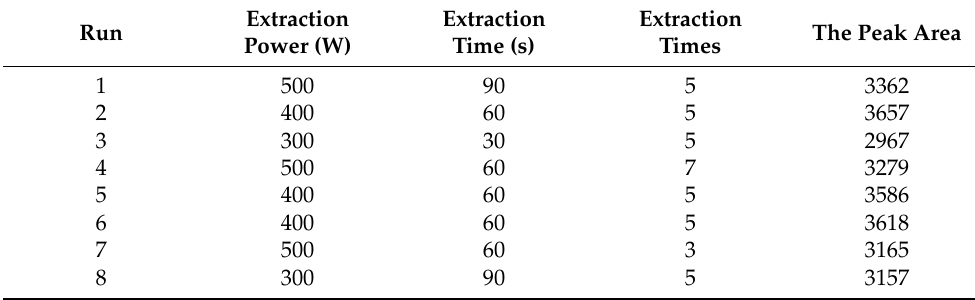
Table 4. The experimental design and data for MAE, obtained via BBD for fatty acids ( n =